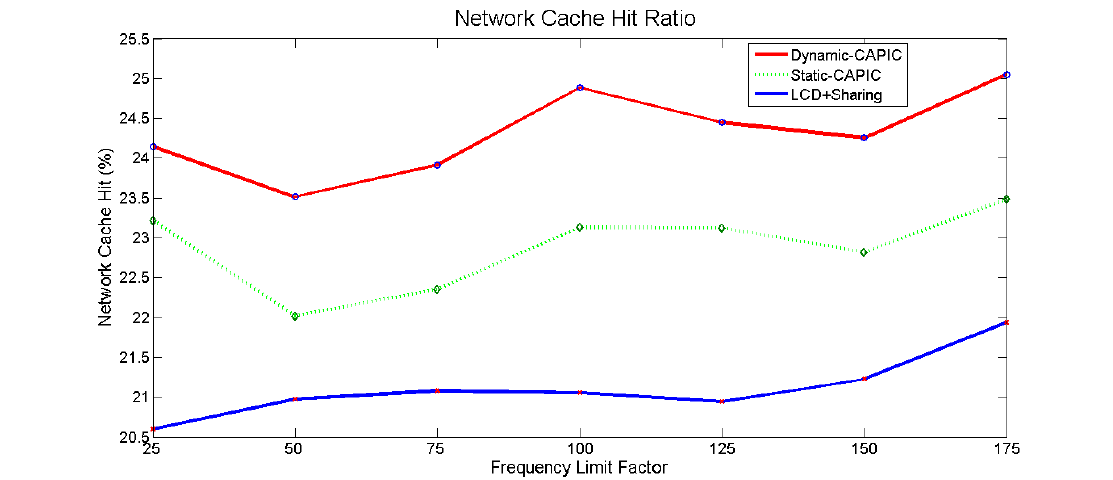
Figure 11. Network cache hit ratio Dynamic-CAPIC, Static-CAPIC, and LCD+sharing scheme.